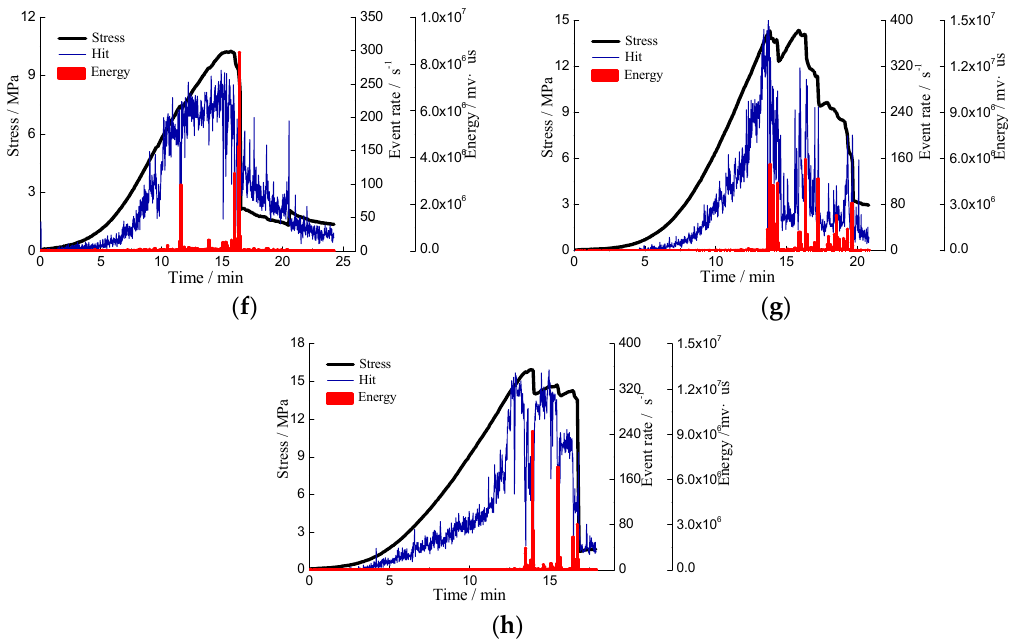
Figure 3. Temporal variation of stress, AE rate, and energy rate of coal specimens. ( a , b ) outburst risk specimens from Yuyang mine: S1, S2. ( c , d ) strong bursting liability specimens from Kouzidong mine: S3, S4. ( e , f ) strong bursting liability specimens from Haishiwan mine: S5, S6. ( g , h ) weak bursting liability specimens from Pingdingshan 10 mine: S7–8. In figures, stress is denoted by thick black curves, AE hit rate by thin blue curve, and AE energy rate by red bar.